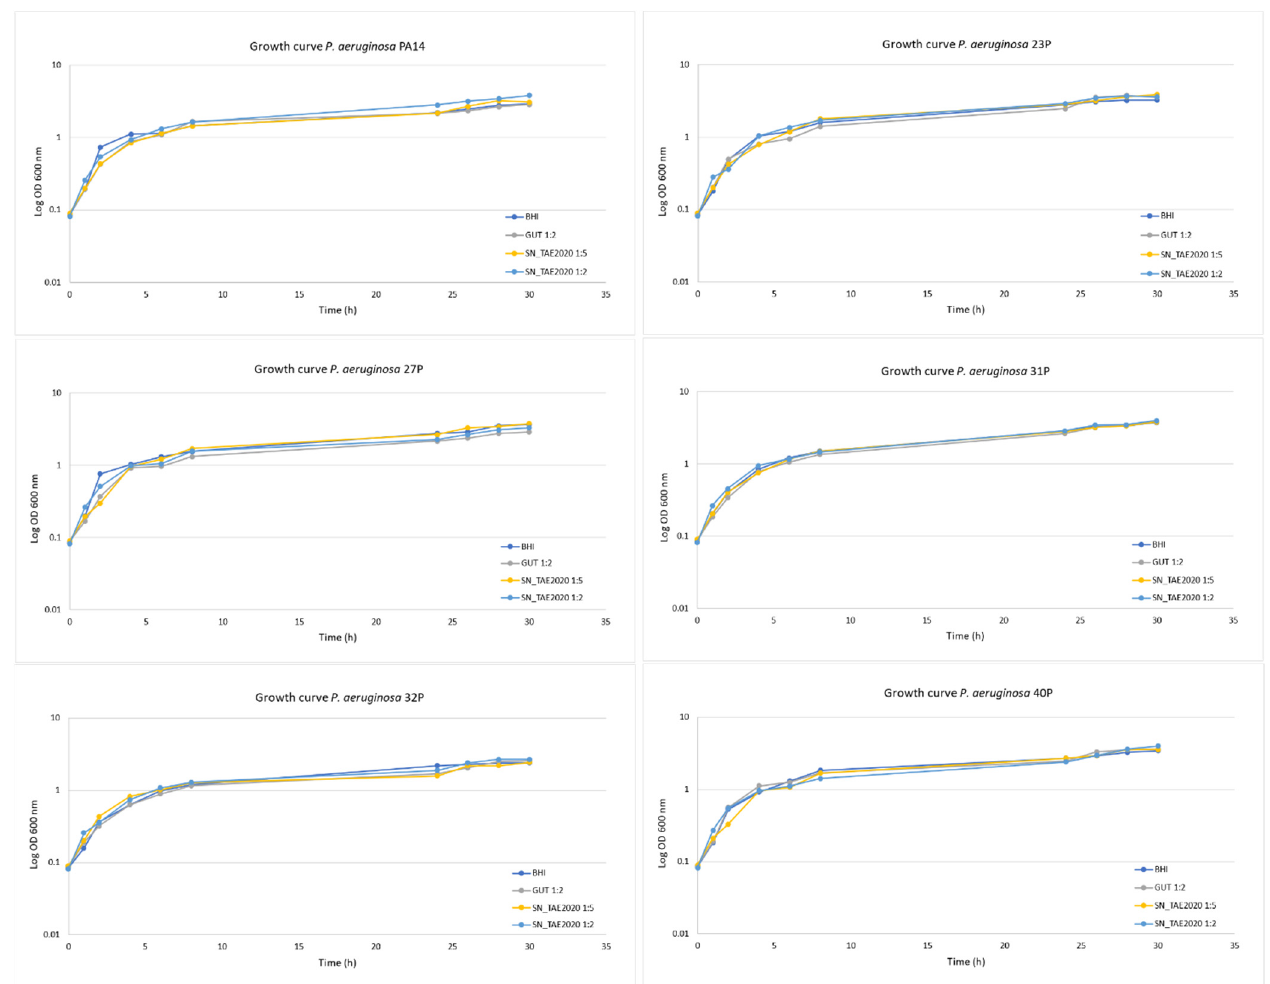
Figure 1. Growth curves of P. aeruginosa bacterial strains at 37 °C at 180 rpm. P. aeruginosa bacterial strains were grown in: BHI, in the presence of 20% and 50% of SN_TAE2020, and in the presence of Gut medium at 50%. Results are representative of three independent experiments.